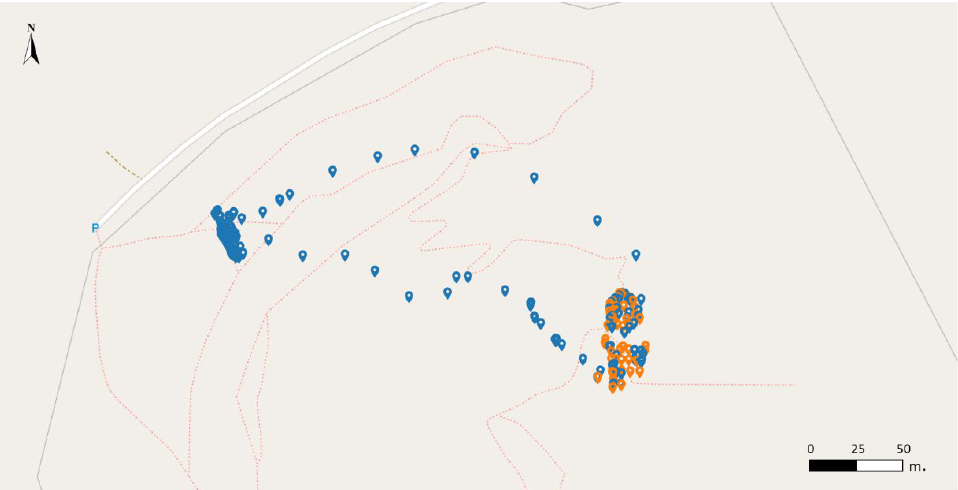
Figure 7. Visualization of trajectory of flight over the Sigri Geopark. Blue-colored points represent raw positions and orange-colored points represent recording positions.